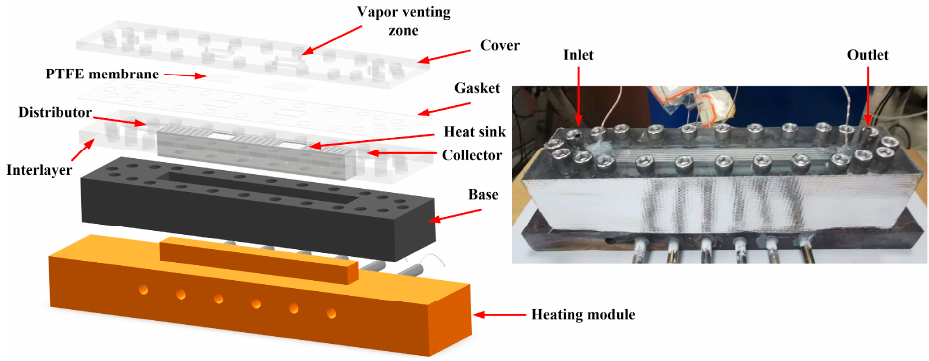
Figure 5. Assembly diagram and photography of test module used in this study.